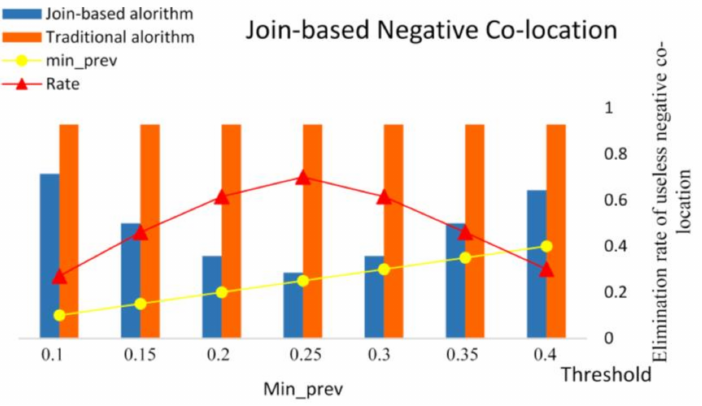
Figure 10. A comparison between the negative C-LP algorithm based on the J-B and traditional algorithms with the change in threshold value (experiment-2).